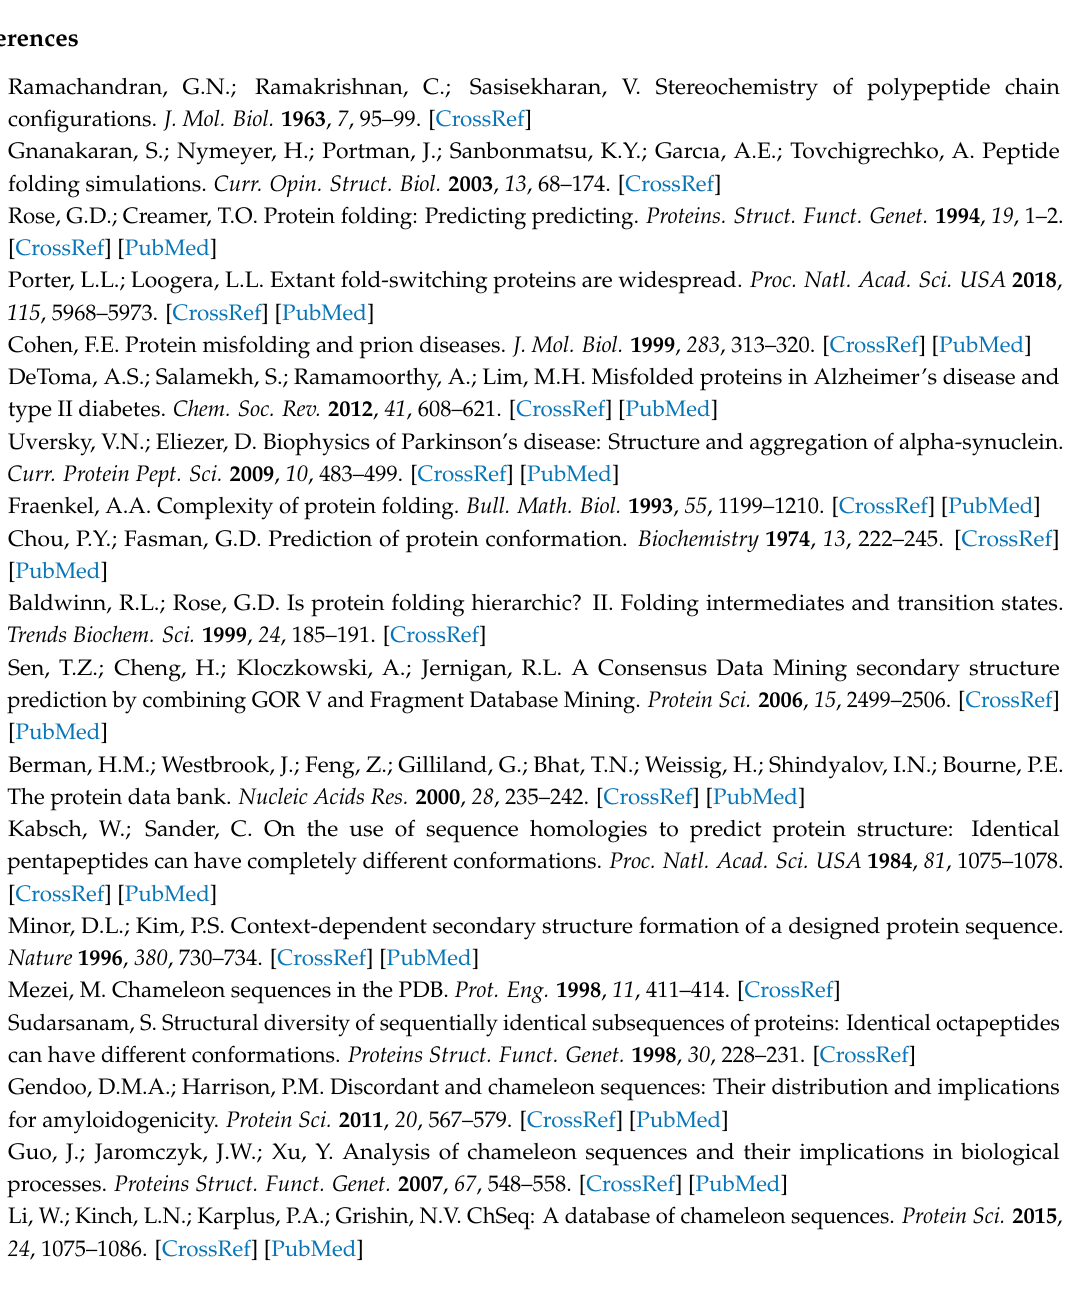
Table S1: List of eight-residue chameleons found, Table S2: List of seven-residue chameleons found. Funding: This research received no external